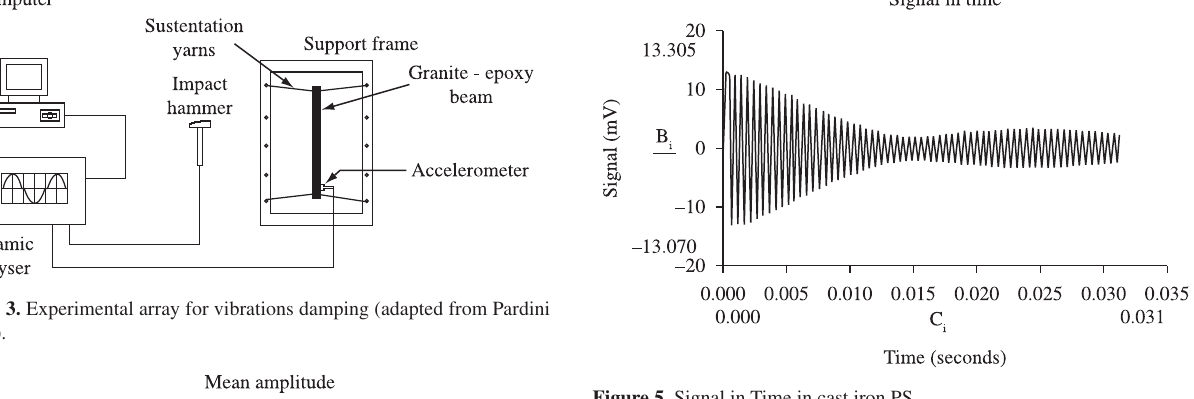
Figure 5. Signal in Time in cast iron PS.